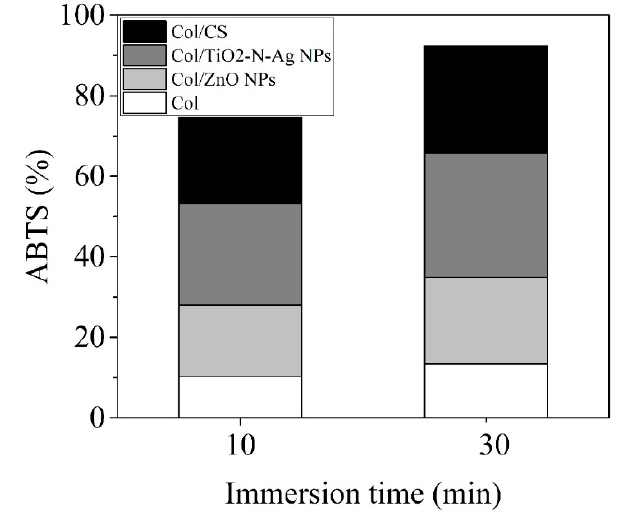
Figure 6. Antioxidant activity of electrospun collagen nanofibers embedded with antimicrobial agents.